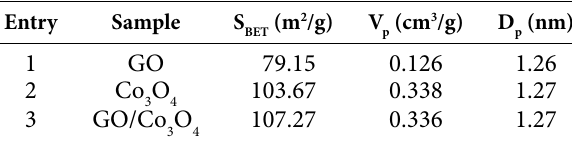
O and GO/Co O 3 4 3 4